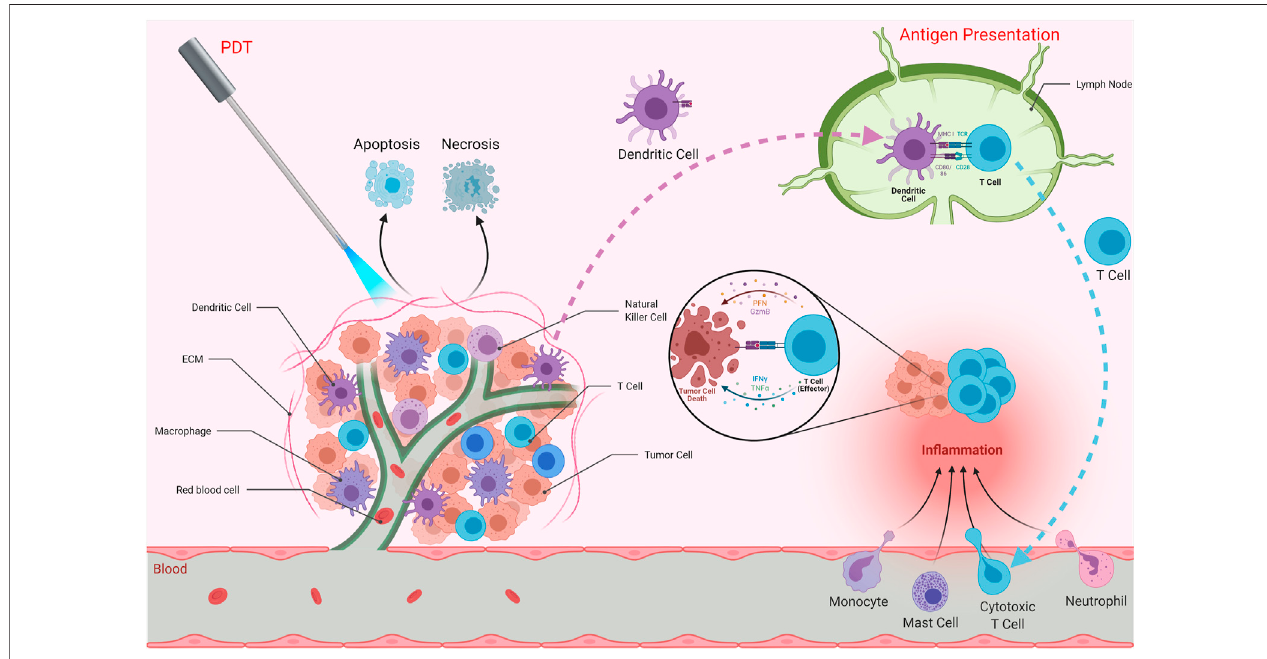
FIGURE2| EffectsofPDTonImmune System.PDTcanaffectimmuneresponsesandinduceanti-tumorimmunityaswellasstimulatingin fl ammation atthetarget tissue.PDTmayresultinapoptosisand/ornecrosisofthetumorcells.Itisalsocapableofinducingimmunogeniccelldeath,whichstimulatesimmuneresponsesagainst deadcellantigens.Theantigensaretakenupbyantigenpresentingcellssuchasdendriticcells.Thesecellsthentraveltosecondarylymphoidorgansinordertopresent those antigens to T cells. Activated Tcells as well as monocytes, mast cells and neutrophils are recruited tothe tumor microenvironment, resulting in in fl ammation. Effector T cells are capable of eliminating tumor cells.